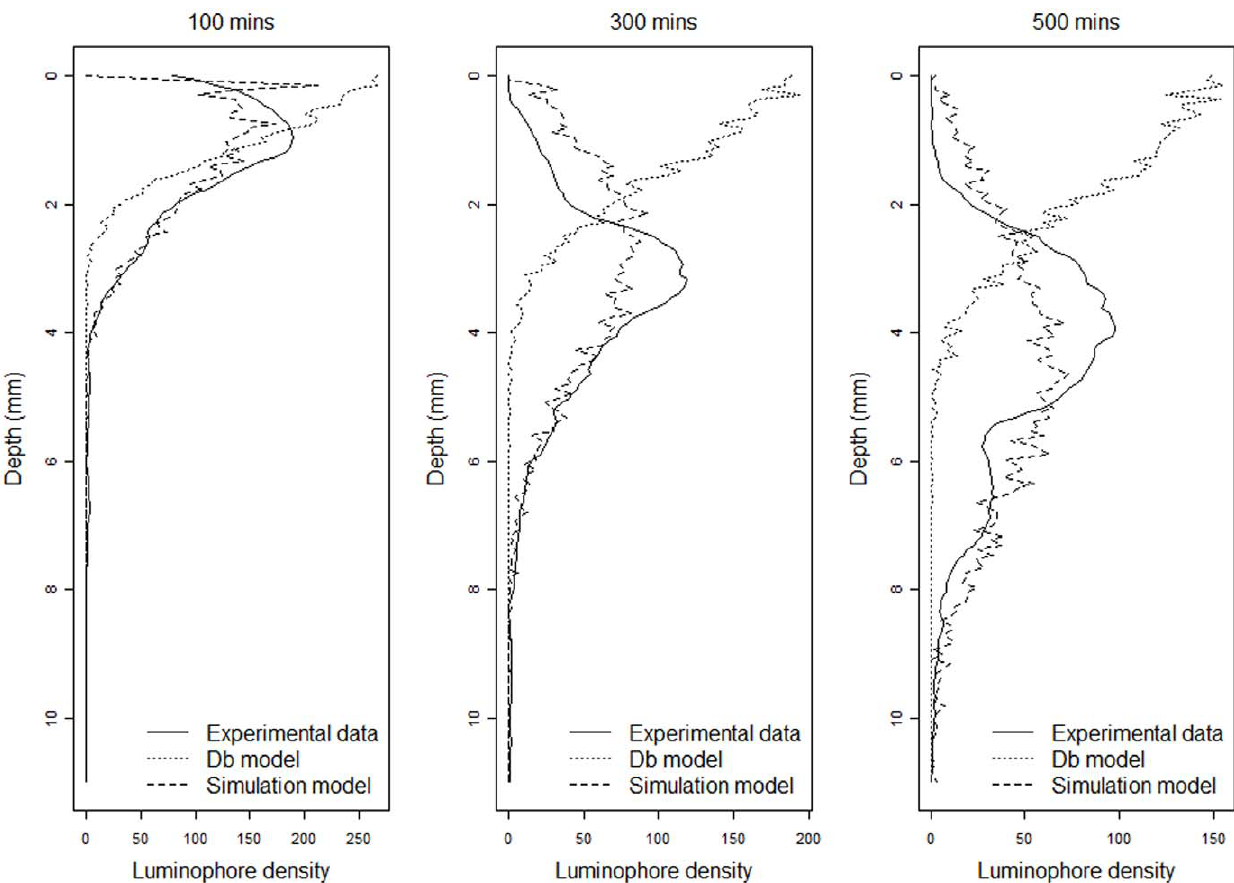
Figure 5. Selected profile examples of experimental data (solid line), Db predictions from a diffusional model fitted analogously to the simulation model (dotted line) and simulation model predictions (dashed line) at time t=100 min, 300 min and 500 min. x-axis depicts number of luminophore pixels in a 300 pixel wide sediment profile.